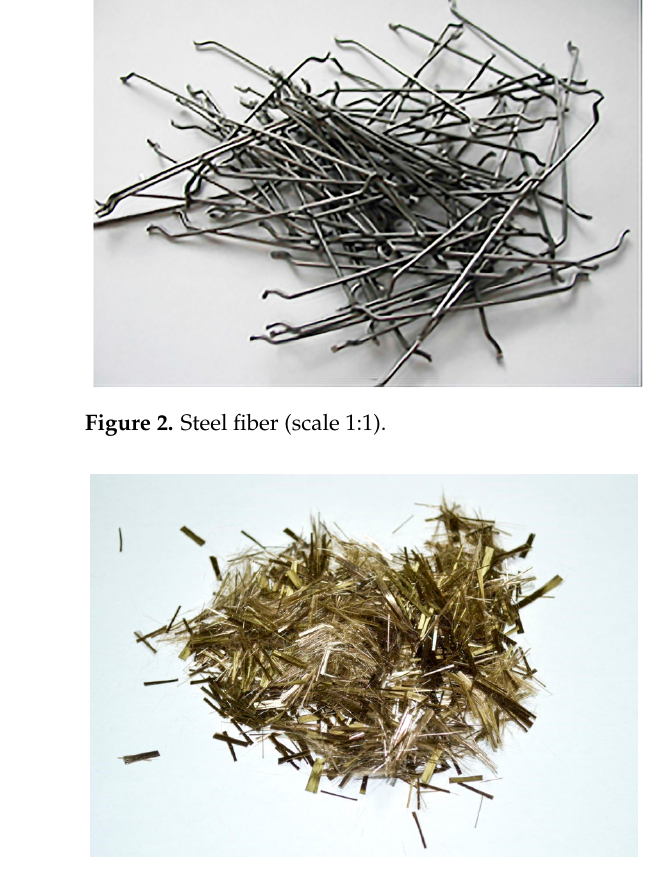
Figure 4. Polypropylene fiber (scale 1:1). The superplasticizer Schomburg Remicrete SP-10 (FM) was used to regulate the mo- bility of concrete mixtures. It is a highly effective polyester carboxylate-based plasticizer that contributes to accelerated early and final strength development by acting on the hy- dration processes. The technical characteristics of the superplasticizer are shown in Table 6.